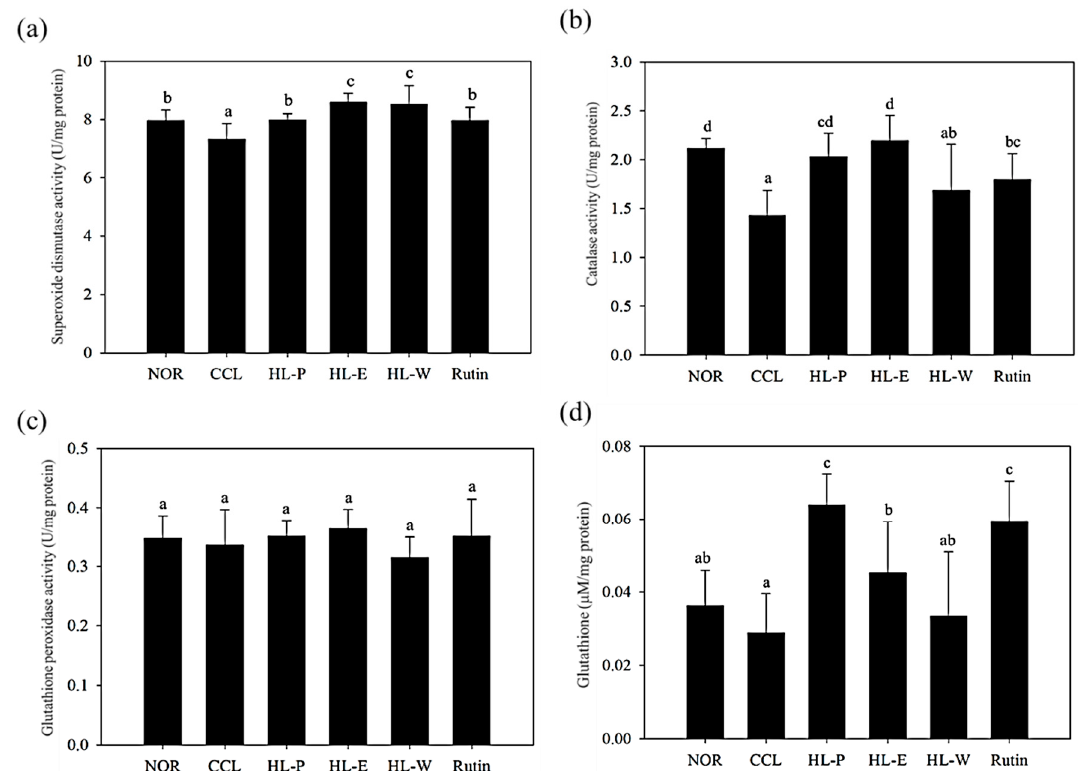
Figure 2. The effects of red quinoa and its extracts on the activities of superoxide dismutase ( a ), catalase ( b ) and glutathione peroxidase ( c ), and the level of glutathione ( d ) of CCl 4 -induced liver injury mice. NOR: normal group, CCL: CCl 4 -induced liver injury mice, HL-P: CCl 4 -induced liver injury mice fed 5.13 g/kg (rutin 8.46 mg/kg) of red quinoa-powder, HL-E: CCl 4 -induced liver injury mice fed 1.54 g/kg (rutin 16.4 mg/kg) of red quinoa-ethanol extracts, HL-W: CCl 4 -induced liver injury mice fed 1.54 g/kg (rutin 3.92 mg/kg) of red quinoa-water extracts, Rutin: CCl 4 -induced liver injury mice fed 16.4 mg/kg of rutin. Data are presented as mean ± SD ( n = 8). a,b,c,d Different letters indicate significantly different values according to a one-way ANOVA using Duncan’s multiple test ( p < 0.05).